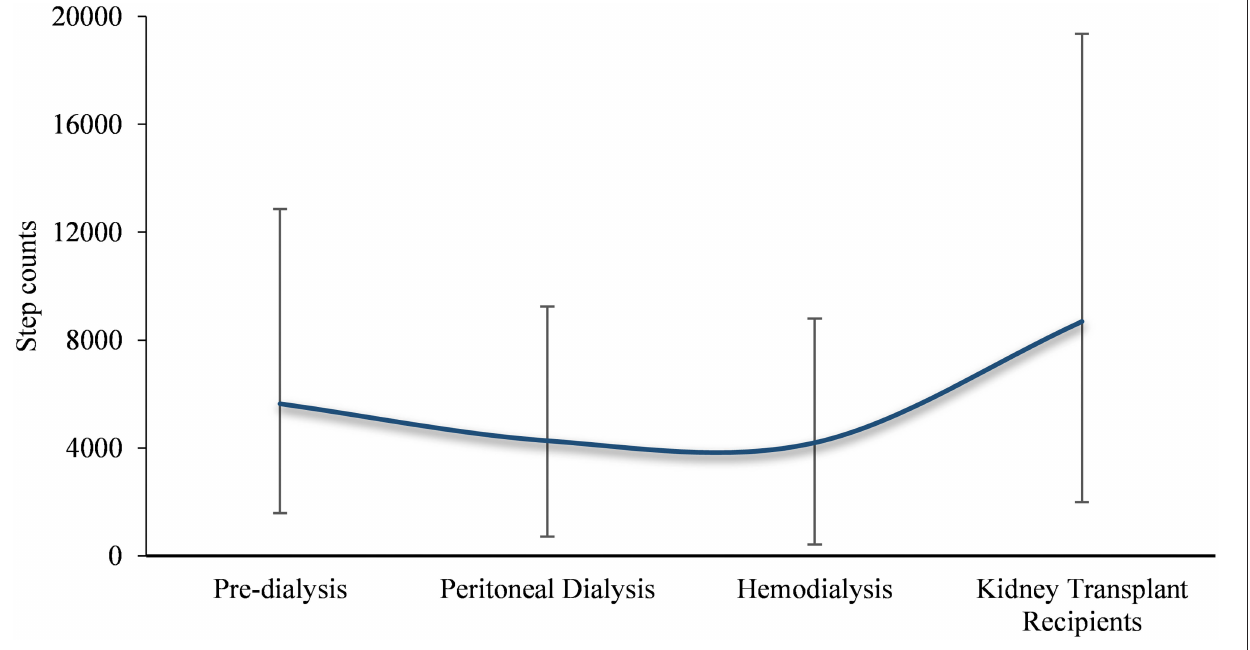
Frontiers in Medicine |